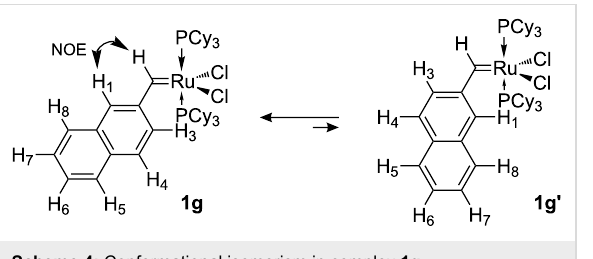
Figure 3: Olefin and alkylidene-proton region of the 1 H NMR (top) and NOE difference spectrum (bottom) of 1e in CD 2 Cl 2 at − 40 °C, satu- rating the methylidene H signal at δ = 18.9 ppm.